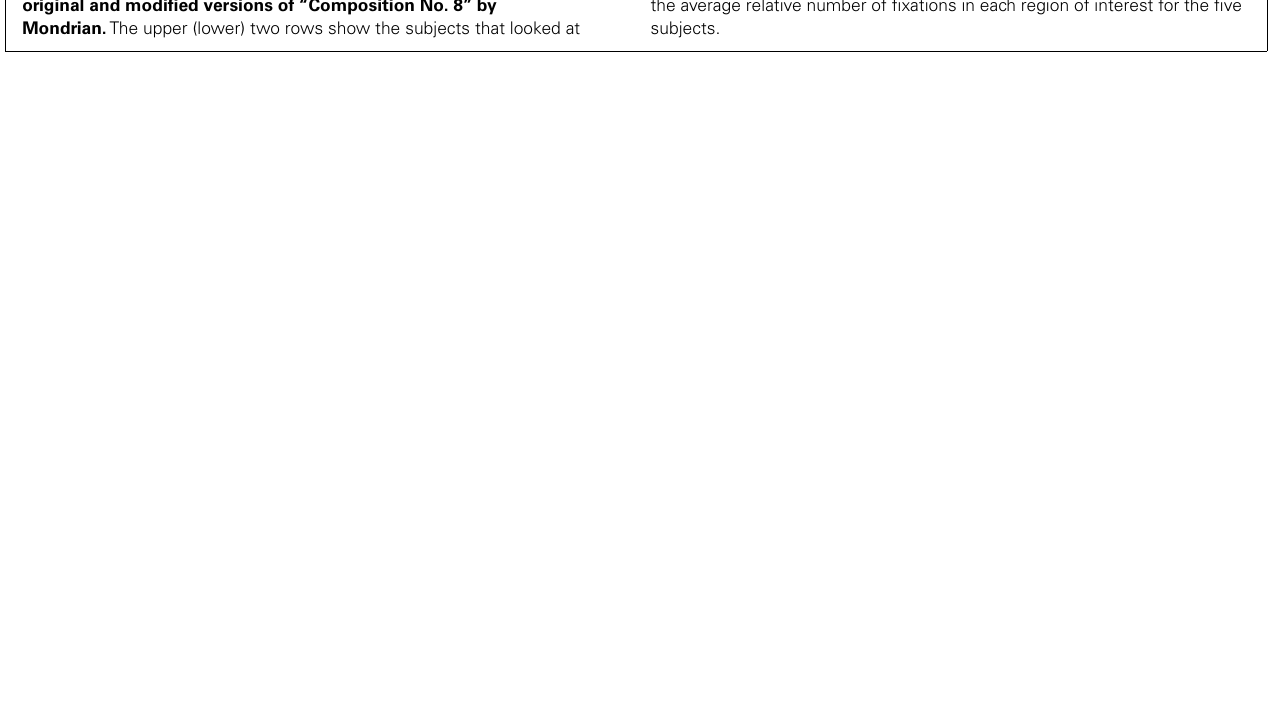
FIGUREA3 | Saccade patterns for all 10 subjects looking at the original and modified versions of “Composition No. 8” by Mondrian. The upper (lower) two rows show the subjects that looked at